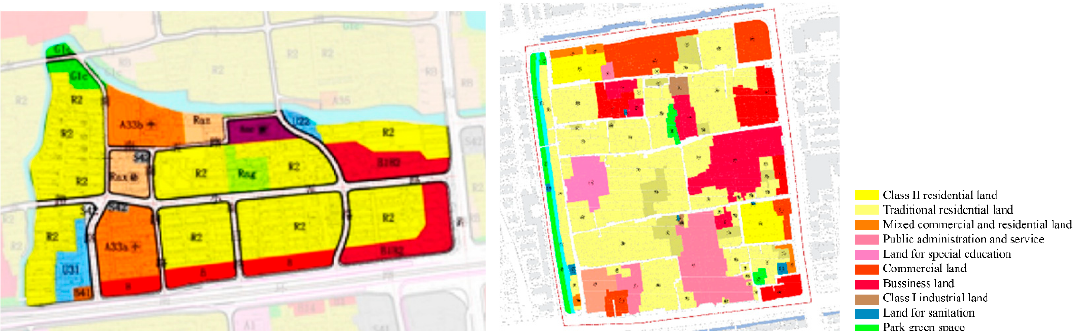
Figure 4. Land use in Nanhuan ( left ) and Daoqian ( right ).